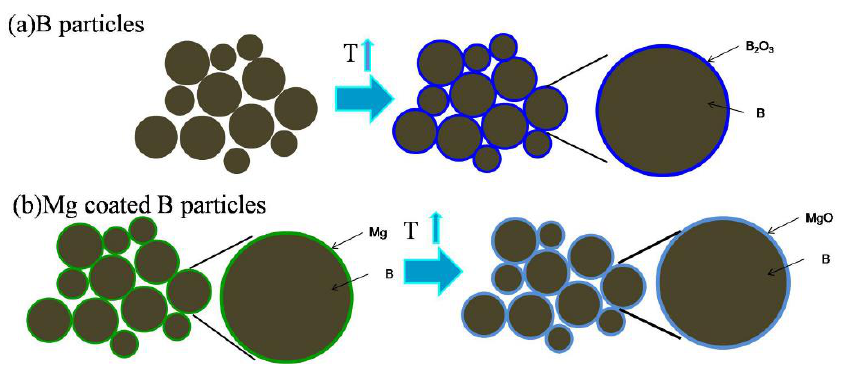
Figure 12. Models of B and Mg/B powder oxidation.